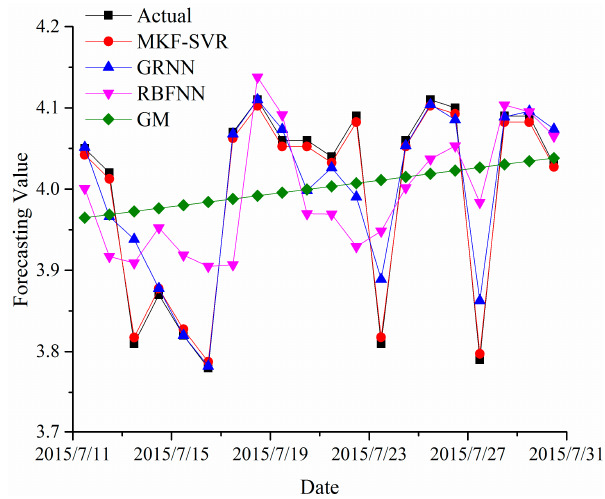
Figure 8. The forecasting values of H 2 (Case 1).